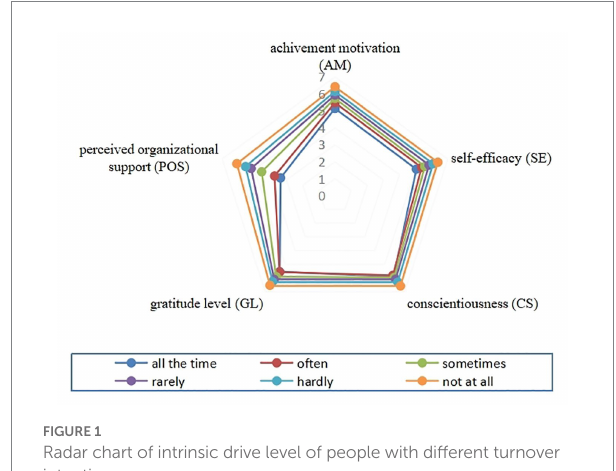
FIGURE 1 Radar chart of intrinsic drive level of people with different turnover